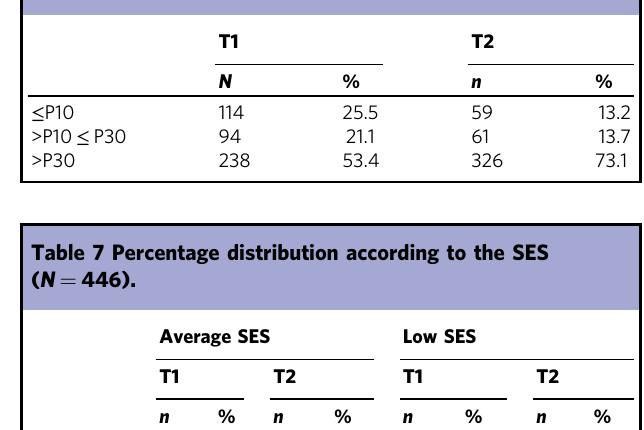
Table 6 Percentile distribution at T1 and T2 ( N = 446).